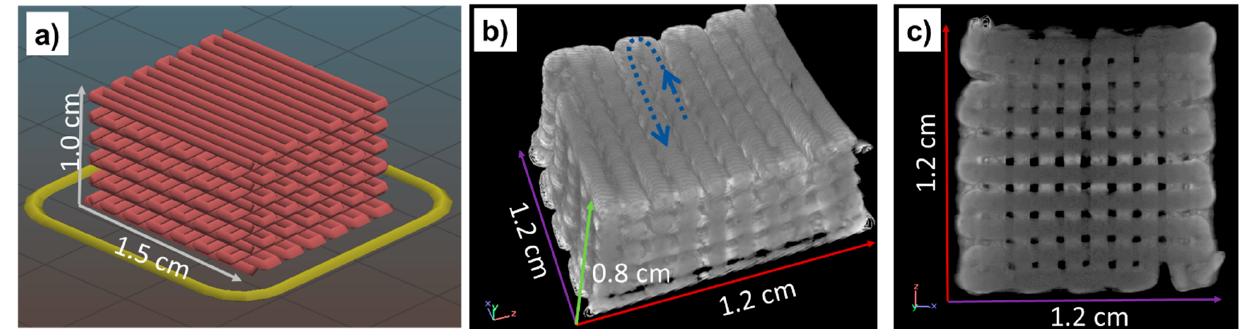
Figure 2. ( a ) CAD/CAM 3D design of the simple cubic geometry of zirconia. Reprinted from Ref. [27] with permission; Copyright Elsevier 2021, ( b ) three-dimensional micro-CT image and ( c ) cross-sectional micro-CT image of the sintered 3D-printed scaffold, with a 50% feed infill of zirconia. The dashed arrow in ( b ) indicates the direction of filament deposition in one single layer.